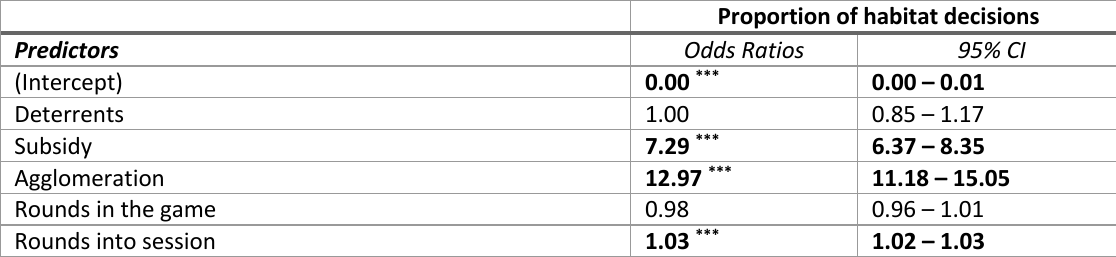
Table A1.5: Odds ratio estimates from the full GLMM model showing the effect of treatments and other households’ characteristics on farmers’ propensity to provide habitats in the games. Random effects included in the model were individuals and